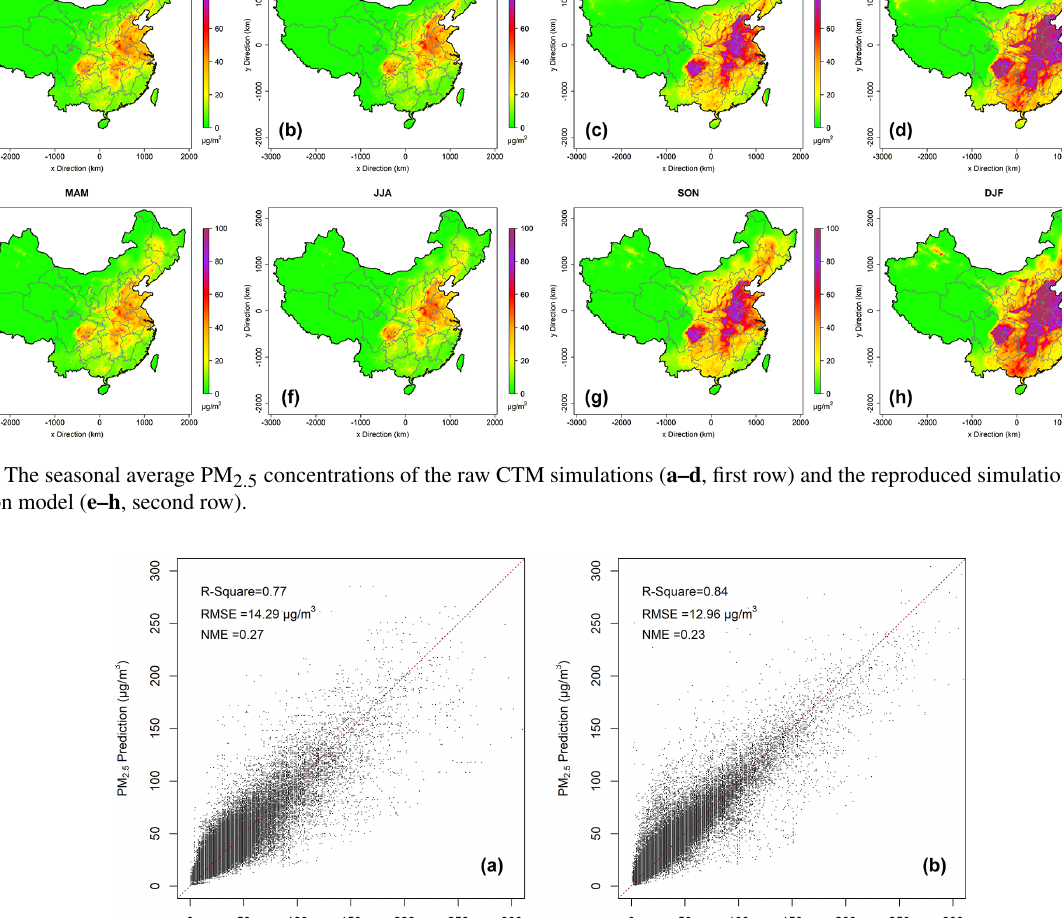
trations in the high-altitude clean Tibetan Plateau region are predicted as low values, the same as observed. High pollution levels in the middle-western Inner Mongolia area of Hohhot, Baotou, and Yinchuan were also well captured in all four sea-